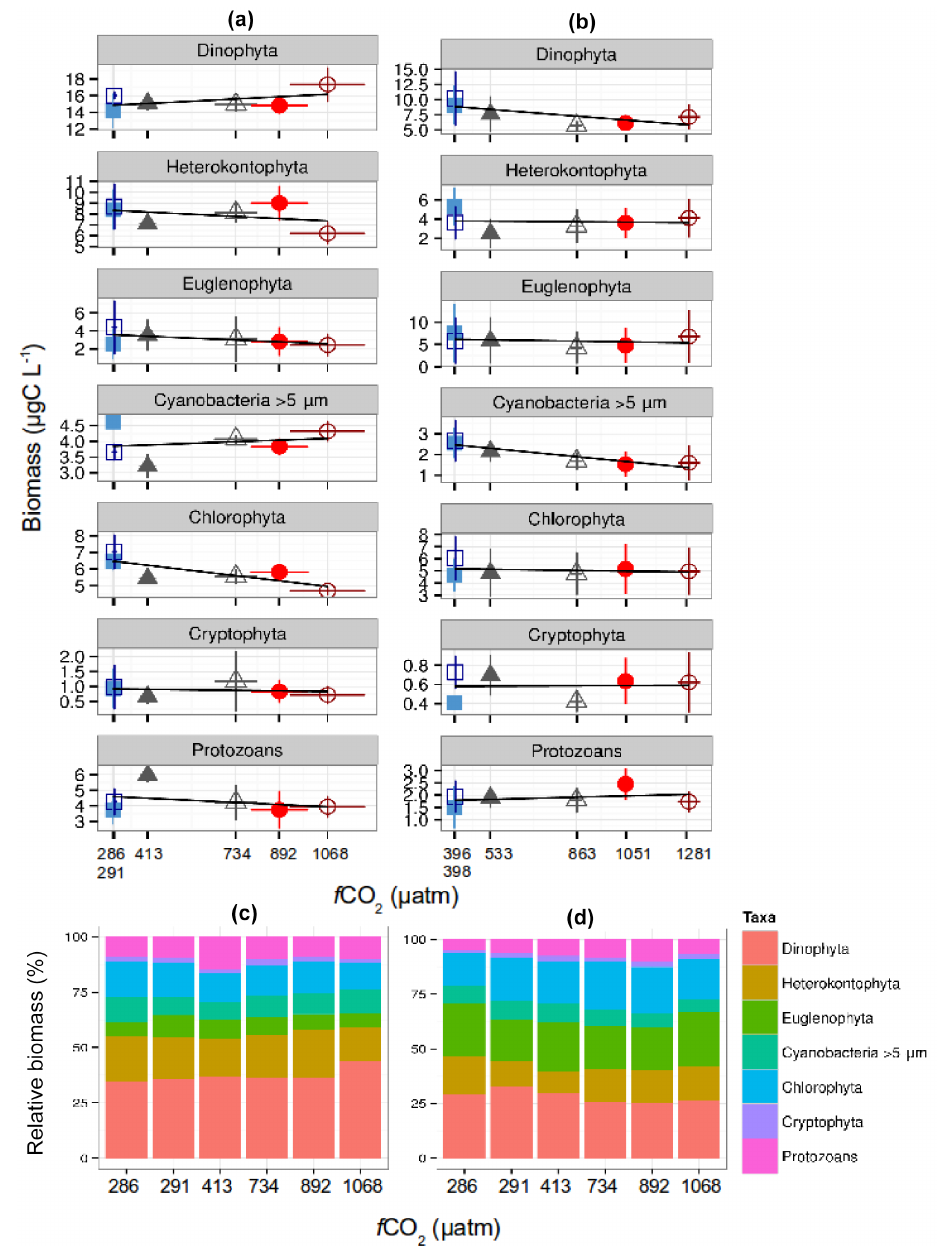
Figure 2. The top panels show the mean of the calculated biomass of each plankton taxon in (a) phase 1, between days 0 and 15 and (b) phase 2, between days 15 and 29, in the CO 2 gradient treatments. The bottom panels show the relative biomass of the different plankton groups between (c) phases 1 and (d) phase 2. The x axes show the measured average f CO 2 in each phase, error bars show standard error in (a) and (b) ( n = 5 for a ; n = 5 for b